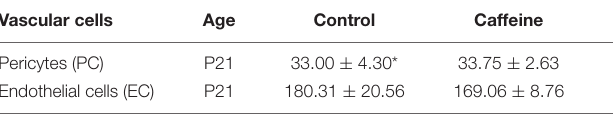
TABLE 2 | Retinal vascular cell density determined in trypsin digest whole mount retina preparations. Vascular cells Age Control Caffeine Pericytes (PC) P21 33.00 ± 4.30* 33.75 ± 2.63 Endothelial cells (EC) P21 180.31 ± 20.56 169.06 ± 8.76 *Mean number of cells per high power field ( × 400). The p-values were calculated by comparing samples from control or caffeine treated mice at P21 and were not